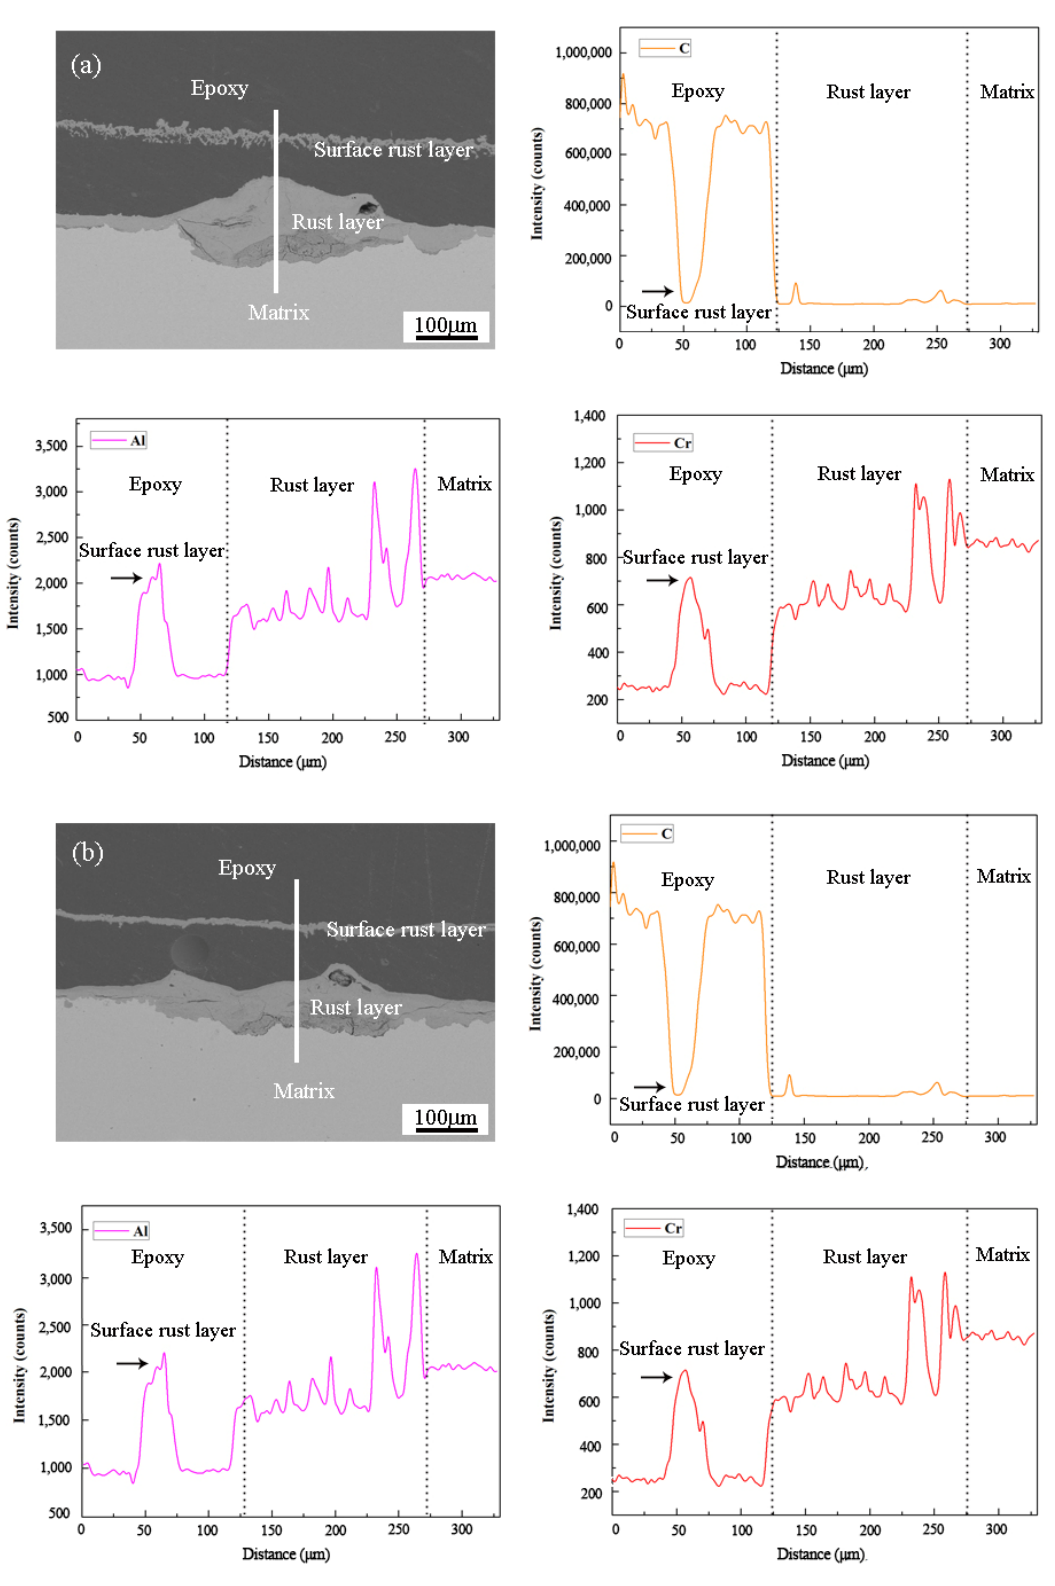
Figure 5. Element distribution in rust layers after 144 h immersion tests ( a ) Q235B ( b ) Q355B.